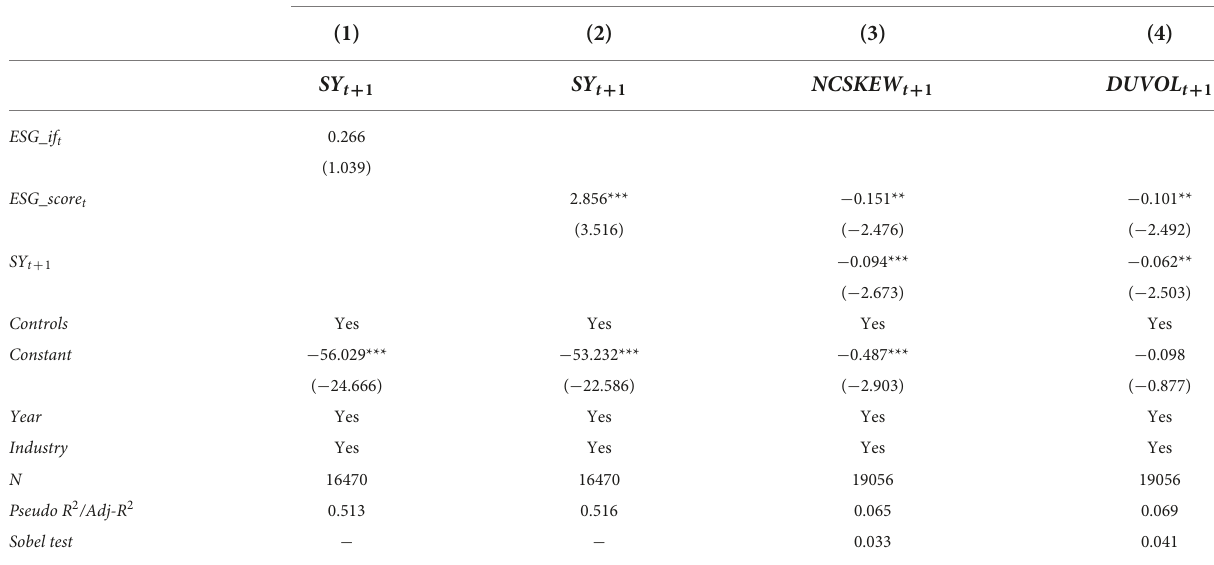
TABLE 10 Mechanism analysis: Reputation capital.